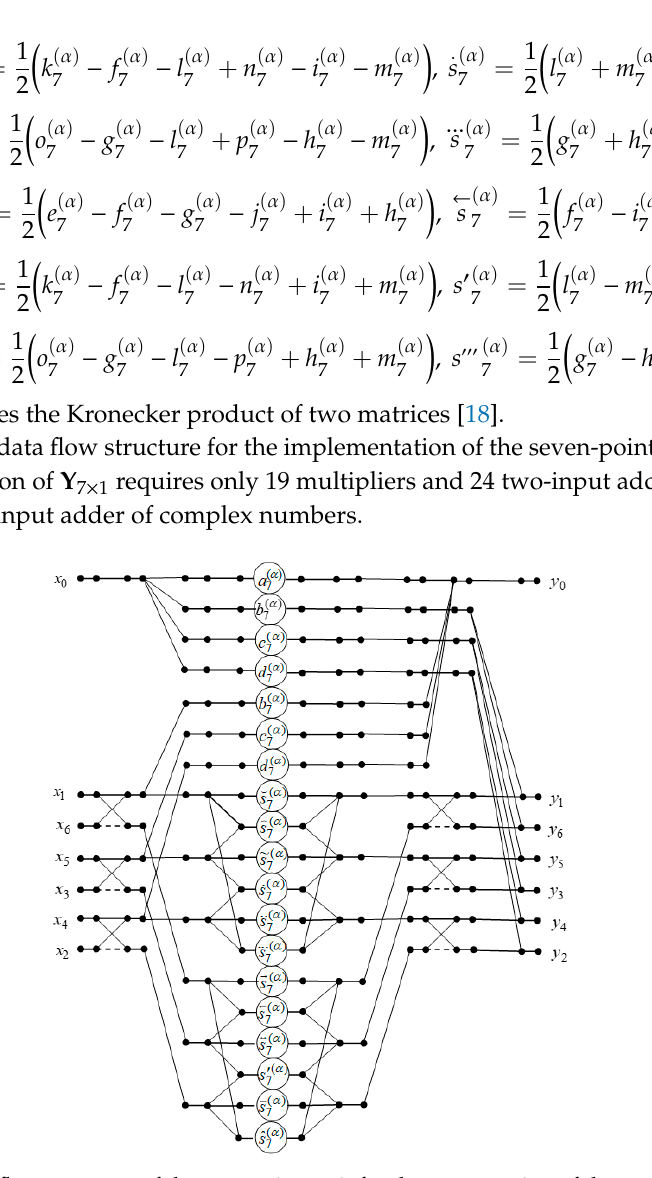
Figure 6. The data flow structure of the processing unit for the computation of the seven-point DFrFT.